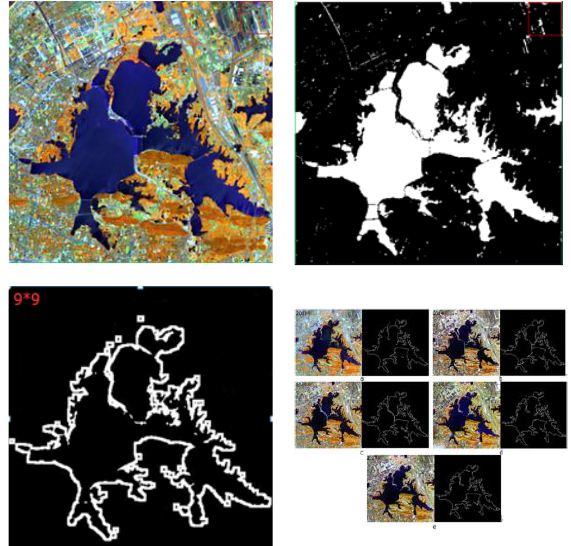
Figure 3. Results of the lake boundary